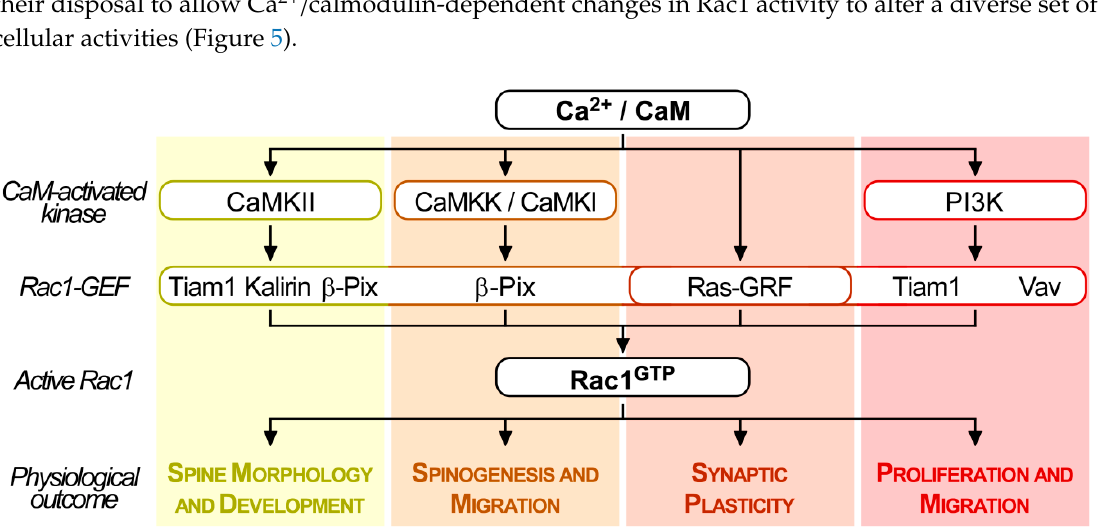
Figure 5. Calmodulin-mediated activation of Rac1-specific GEFs controls multiple Rac1-dependent cellular functions. This scheme highlights the ability of Ca 2 + / calmodulin (Ca 2 + / CaM) to bind and activate several kinases, including calcium / calmodulin-dependent protein kinase I and II (CaMKI, CaMKII), CaMK kinase (CaMKK) and phosphoinositide 3-kinase (PI3K). This leads to the activation of Rac1-specific guanine nucleotide exchange factors (Rac1-GEFs), including T-lymphoma invasion and metastasis-inducing protein 1 (Tiam1), PAK-interacting exchange factor β ( β -PIX), kalirin, Ras guanine nucleotide releasing factor (RasGRF), and Vav. These Rac1-GEFs then promote GTP loading of Rac1, promoting Rac1 activation, which is associated with fundamental cellular activities, including spine morphology and development, spinogenesis, synaptic plasticity, proliferation, and migration (see text for further details).